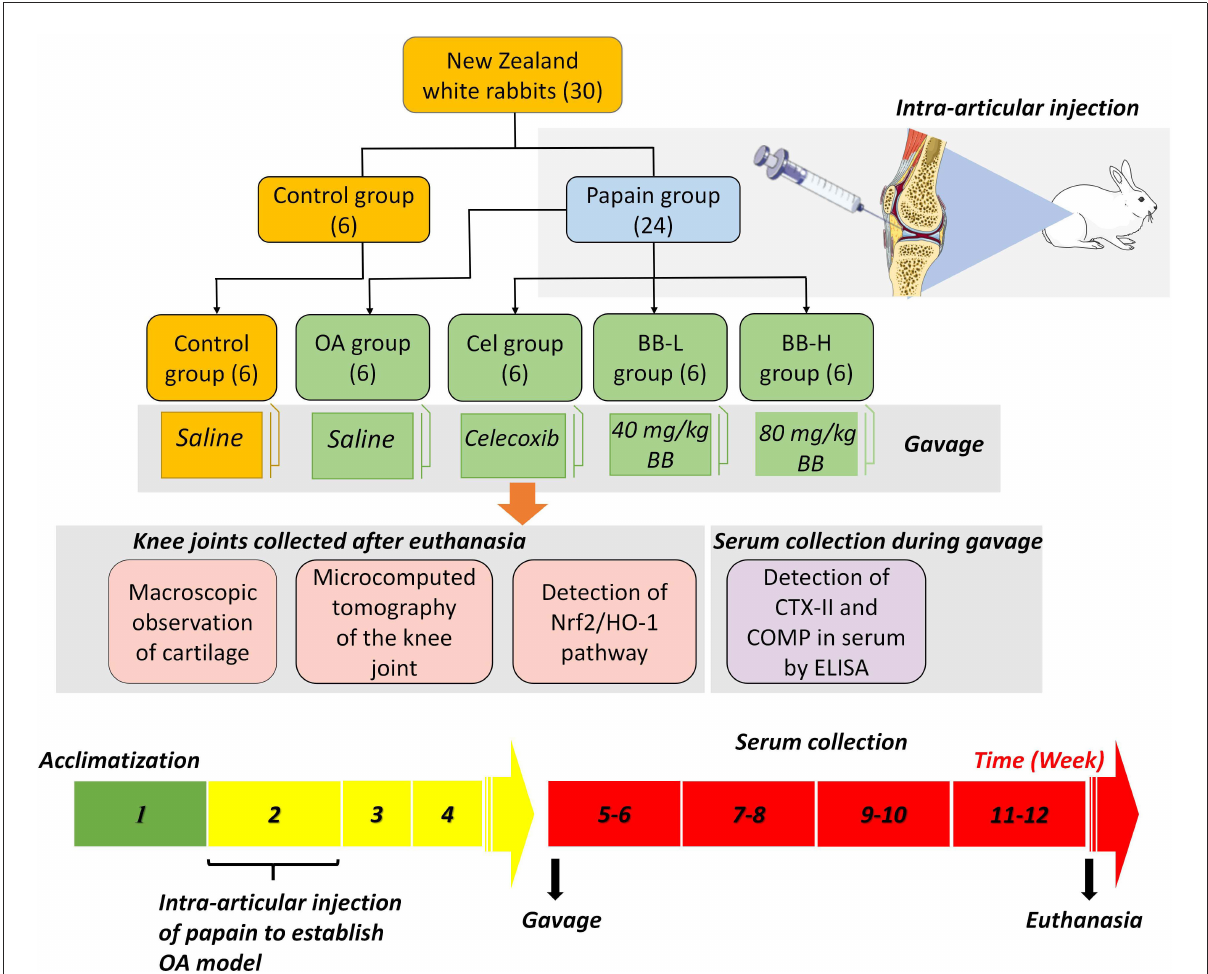
FIGURE1 Papain-induced rabbit osteoarthritis model: experimental grouping, dosing frequency, and experimental design.